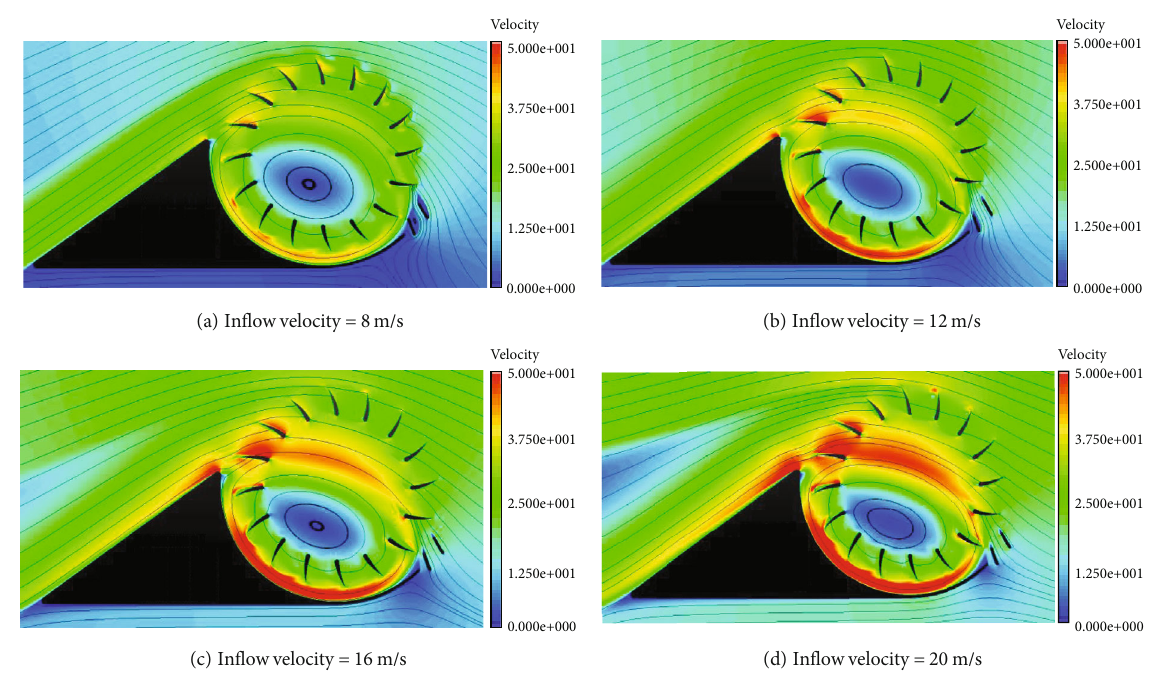
Figure 13: Velocity nephogram and streamline diagram of a double leading edge winglet ( installationangle = 60 ° , α = 0 ° ).